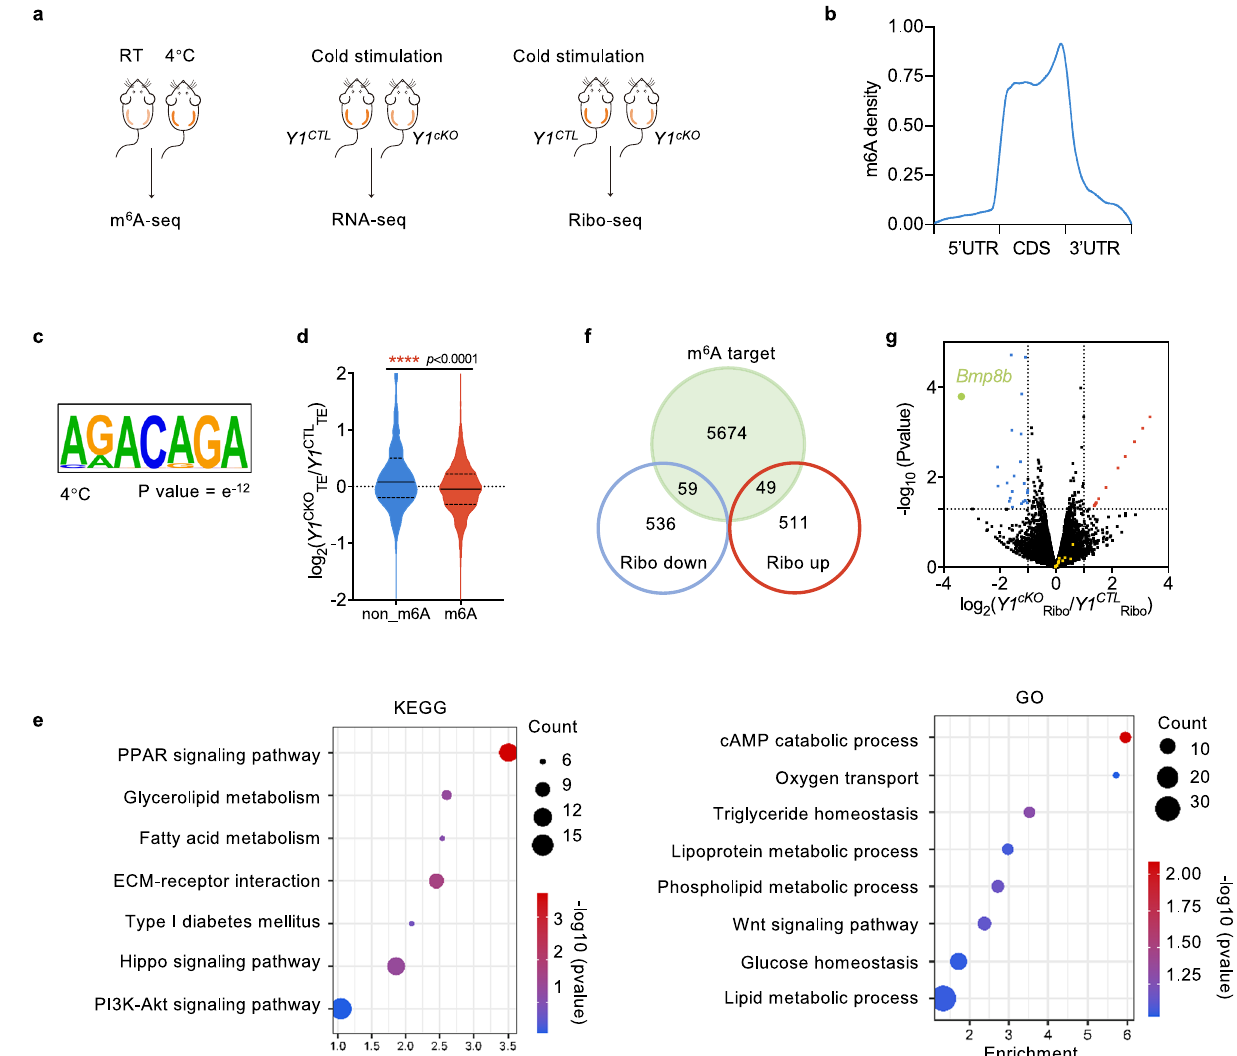
Fig. 4 | Transcriptome ‐ wide identi fi cation of YTHDF1 ‐ regulated transcripts in beige adipose tissue. a Schematic description of the m 6 A-seq and RNA-seq, and Ribo-seq experiments. b Metagene plot of m 6 A peak distribution in iWAT at 4°C. c Consensus motif of m 6 A sites in beige adipose tissue. d Violin plots showing TE changes between Ythdf1 CTL and Ythdf1 cKO mice for nonmethylated (non ‐ m 6 A) and methylated (m 6 A) transcripts. **** P <0.001, Mann – Whitney test. No adjustments. e Top KEGG and GO analysis terms enriched for transcripts during beiging and